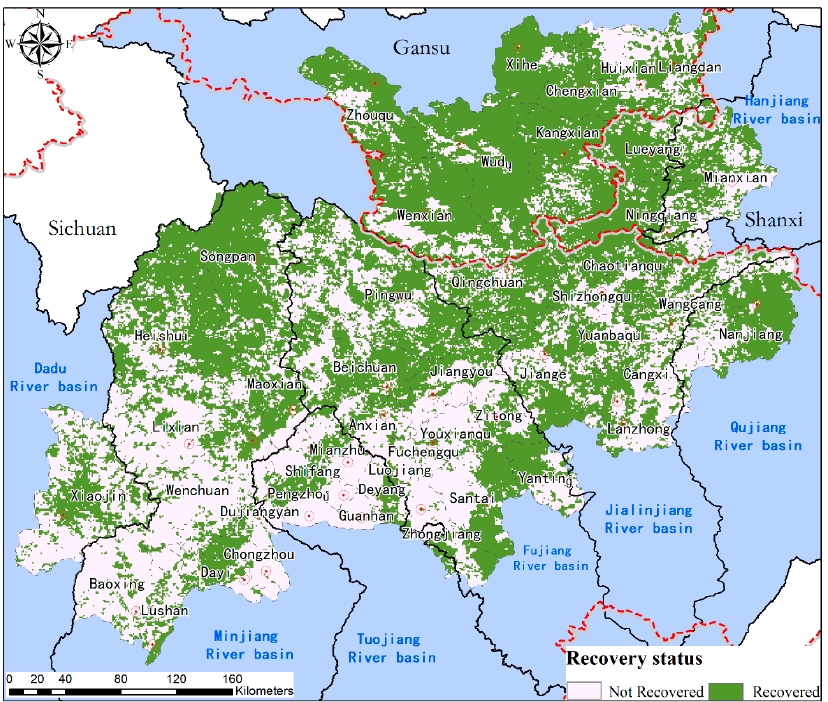
Figure 8. Recovery status in the decade (2018) after the earthquake (based on the pre-earthquake level of 2007).